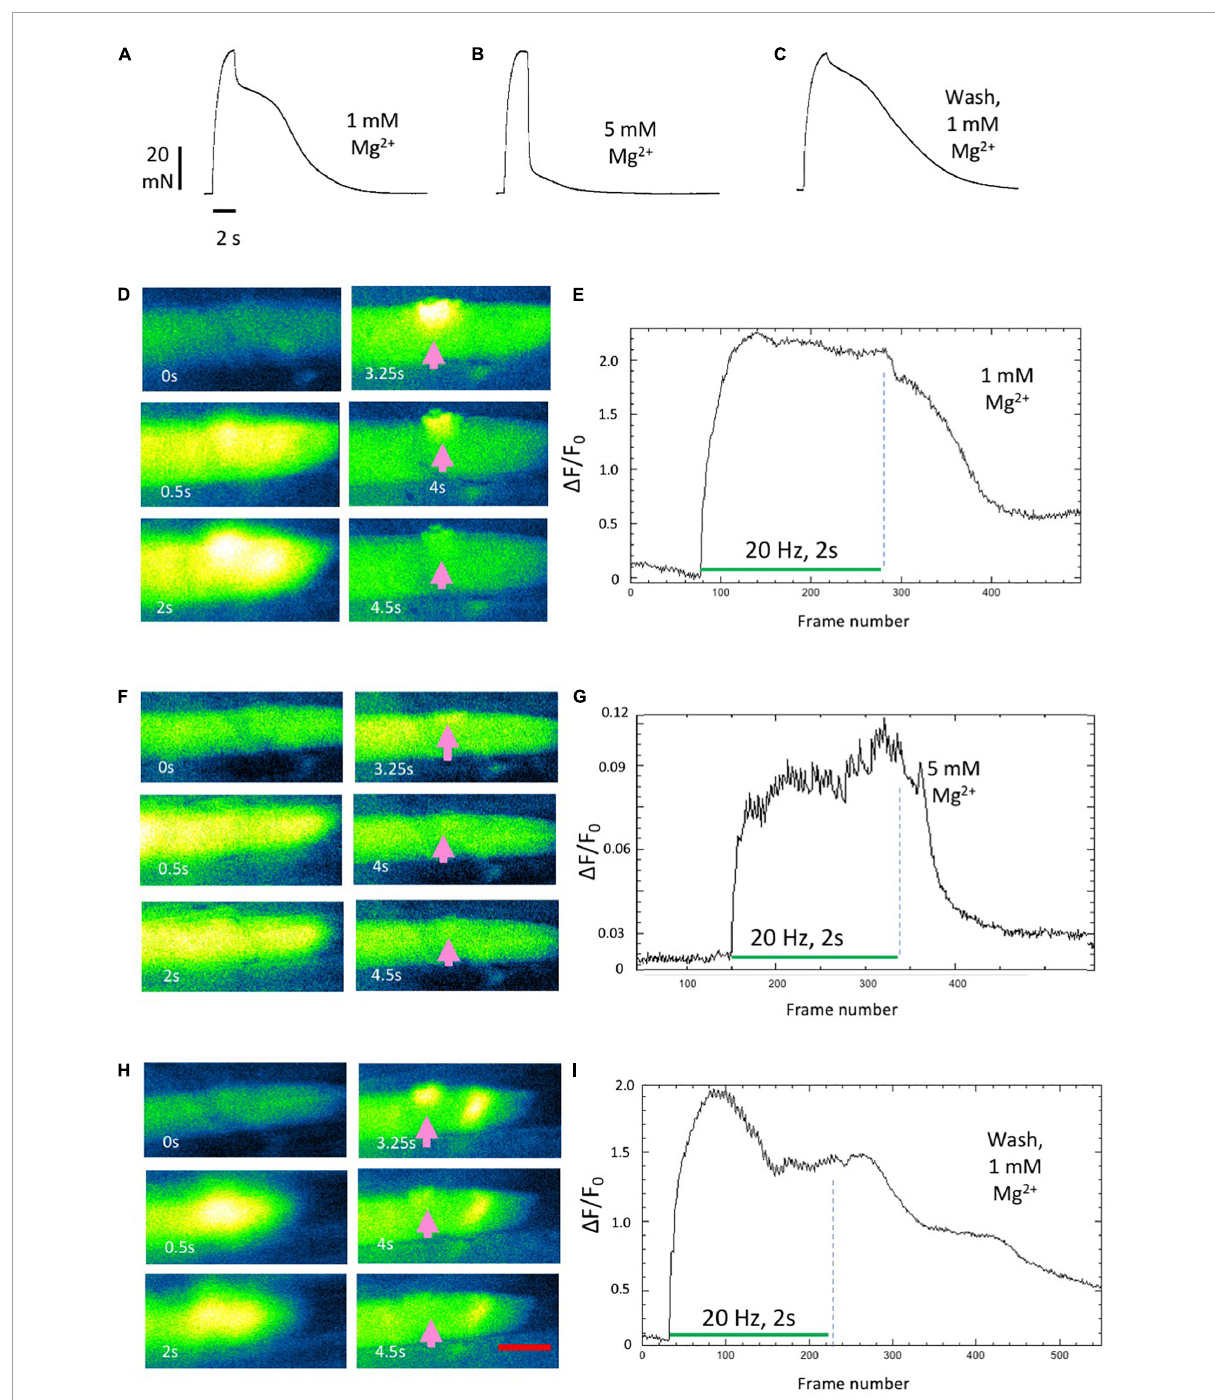
FIGURE6 Aftercontractions of isolated mouse FDB muscles are reversibly mitigated by increasing extracellular Mg 2 + . (A–C) Isometric force recordings from an FDB muscle following approximately 1 h incubation in omethoate (150 µ M). Increasing Mg 2 + to 5 mM (B) abolished the aftercontraction, while leaving the response during the stimulus train unchanged. Aftercontraction immediately resumed after restoring Mg 2 + to 1 mM (C) . (D,E) Fluo-4 images (D) and endplate ROI intensity plots in an FDB muscle during repetitive stimulation (20 Hz, 2 s), following 1 h incubation in omethoate. Intense endplate fluorescence (arrows) and contracture decayed slowly after the end of the stimulus train. (F,G) After increasing extracellular Mg 2 + to 5 mM, stimulation provoked a weaker Ca 2 + signal that decayed rapidly than in n 1 mM Mg 2 + . (H,I) Prolonged endplate Ca 2 + fluorescence immediately returned after restoring Mg 2 + to 1 mM. Appearance of an apparent ectopic region of fluorescence is unexplained but may have been due to an endplate in a different muscle fiber that drifted into the image plane. See Supplementary Videos 5 – 7 . Calibration bar in panel (E) 20 µ